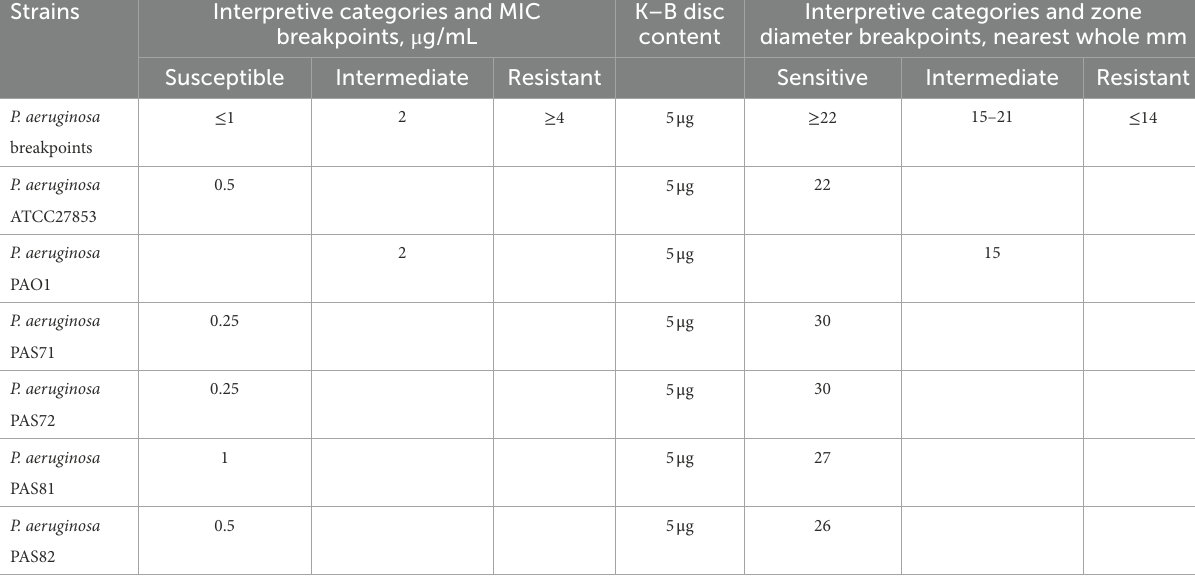
TABLE 1 Minimum inhibitory concentration (MIC) and Kirby–Bauer (K–B) test results of levofloxacin against the six strains of Pseudomonas aeruginosa. Strains Interpretive categories and MIC